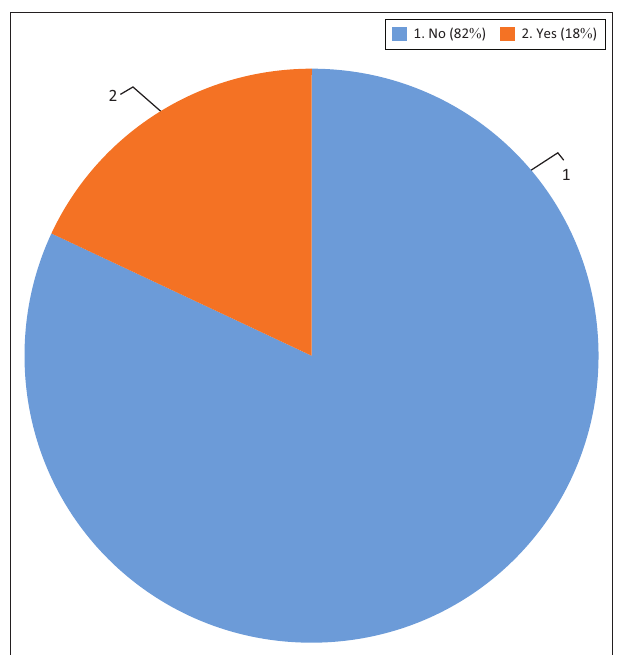
FIGURE 7 : Community knowledge on legislative frameworks for public